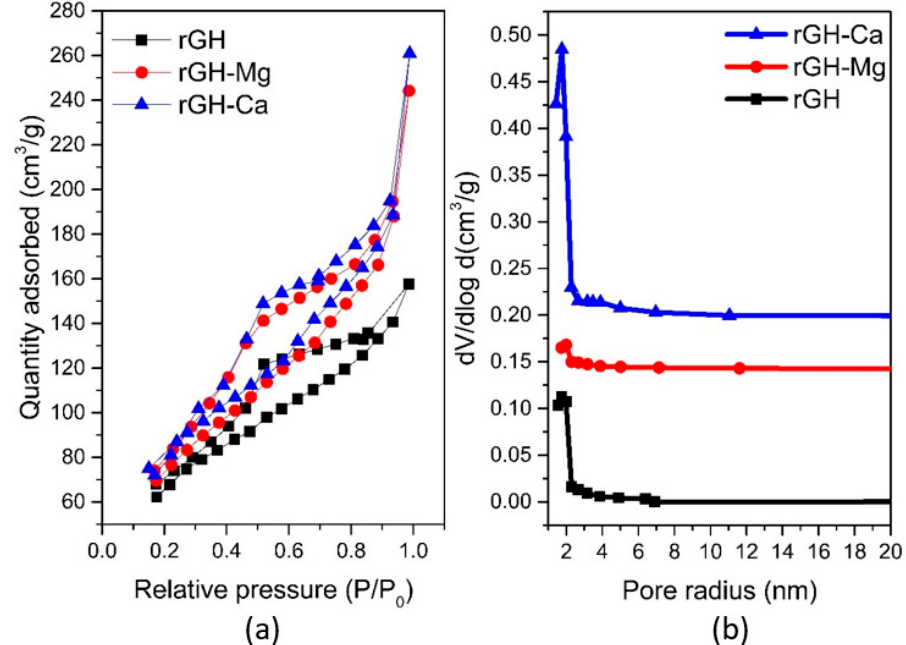
Figure 4. ( a ) N 2 adsorption-desorption isotherm and ( b ) Barrete–Joynere–Halenda (BJH) pore size distribution of the freeze-dried rGH, rGH-Mg, and rGH-Ca.